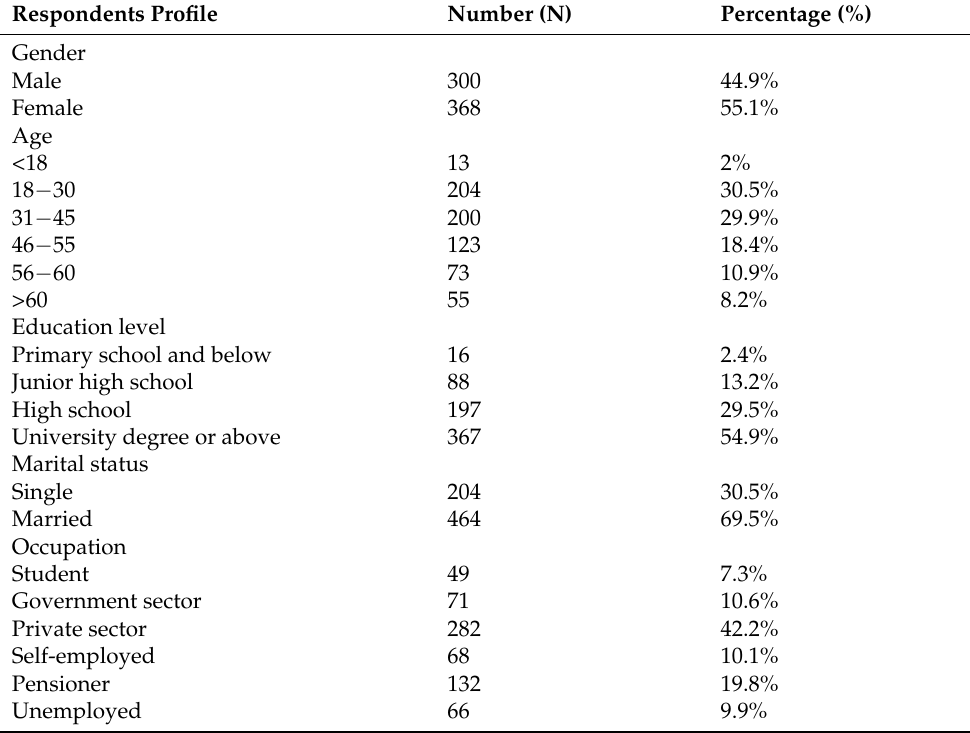
Table 1. Demographic background of the respondents (N =